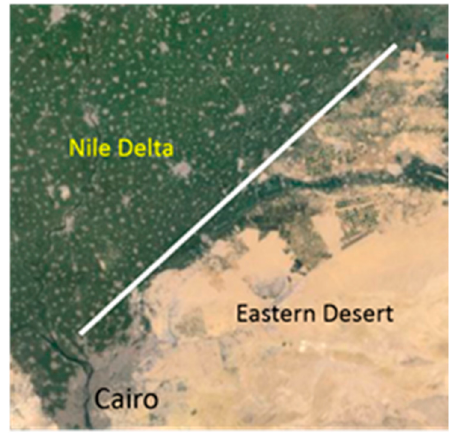
Figure 10. Map showing the sharp boundary between the Nile Delta and Eastern Desert, which coincides with a visible boundary that separates high and low AOD in the spring, summer and fall seasons in the AOD maps over Cairo (Figure 9) (source: Google map).